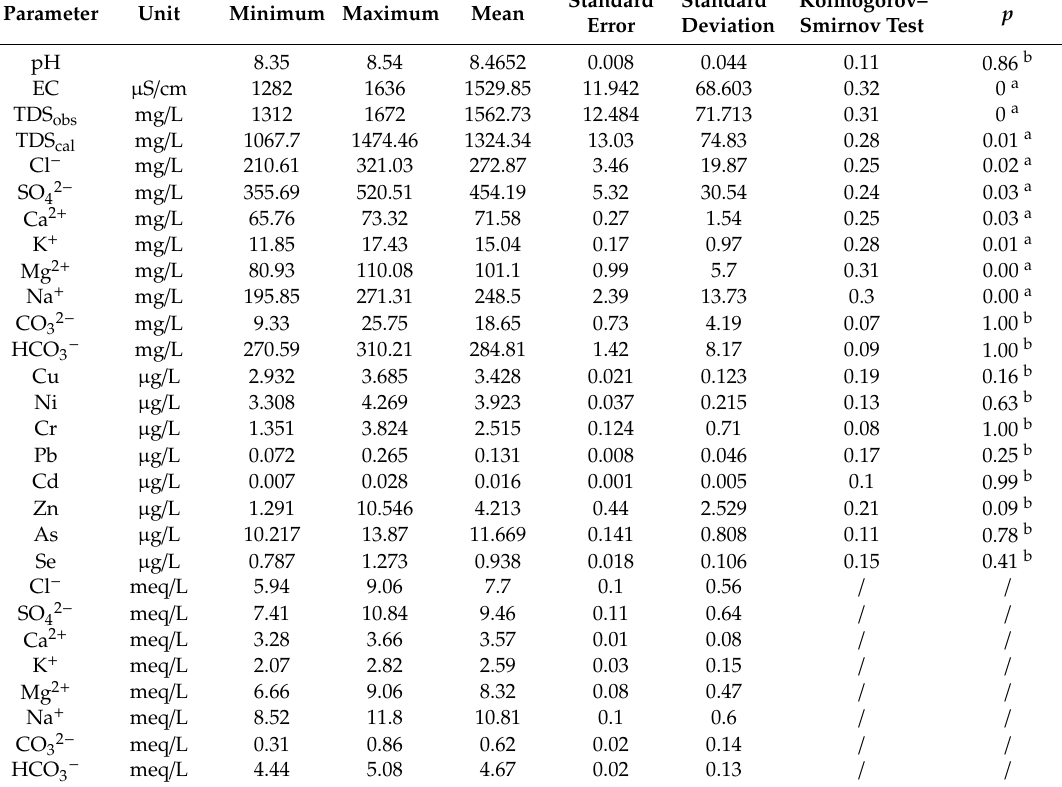
Table 1. Descriptive statistics and normality test (Kolmogorov–Smirnov) of the hydrochemical parameters of Bosten Lake (n =